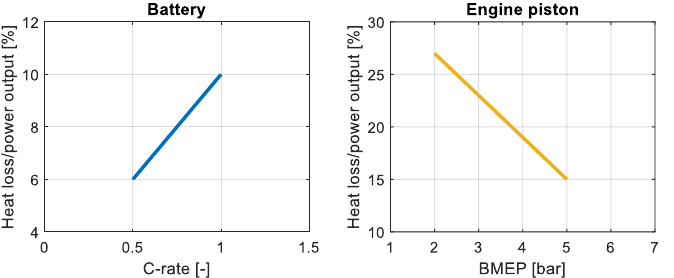
Figure 14. Indicative trend of the heat losses/power output ratio for the battery and the engine increasing the load demand.